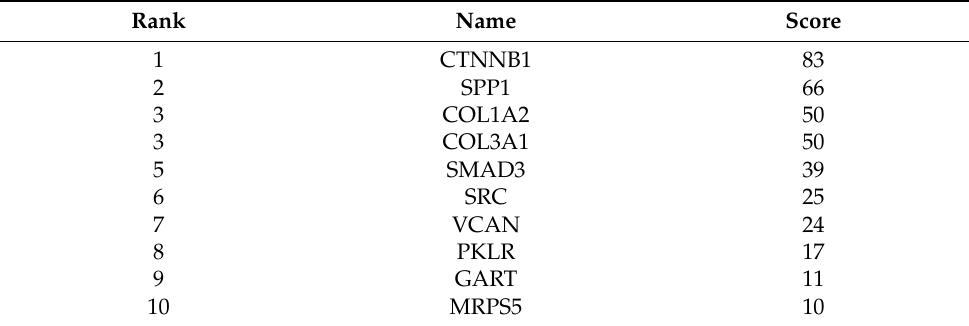
Table 1. Top 10 hub genes produced by protein–protein interaction network